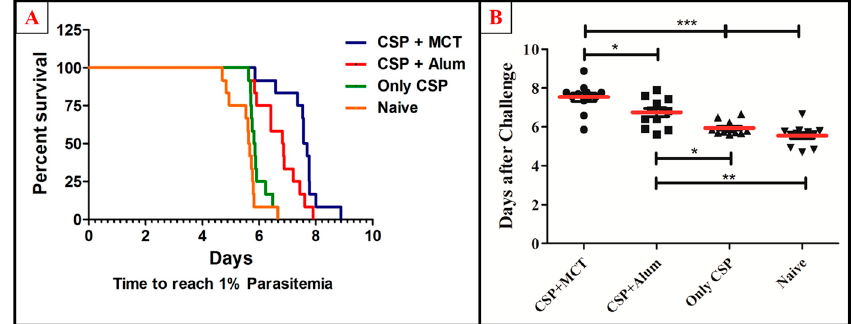
Figure 6. Survival curve and comparative analysis of challenge with P. berghei expressing CSP of P. vivax . Mice were immunized as described in Figure 3 and challenged on day 42. (A) Kaplan Meyer curve for the time until mice have more than 1% of the erythrocytes infected. (B) Number of days until mice have more than 1% of erythrocytes infected. MCT + CSP induced significantly better protection than the group vaccinated with CSP formulated in Alum ( p = 0.0148). Moreover, CSP formulated in MCT induced highly significant protection compared to control mice( p = 0.0001). The data represent pooled results of 2 independent experiments (6 mice per group in each experiment), and were analyzed using GraphPad Prism software applied to assess the means of groups by Tukey’s Multiple Comparison Test of one-way ANOVA. *** p value < 0.0001; ** p value < 0.001; * p value < 0.01.